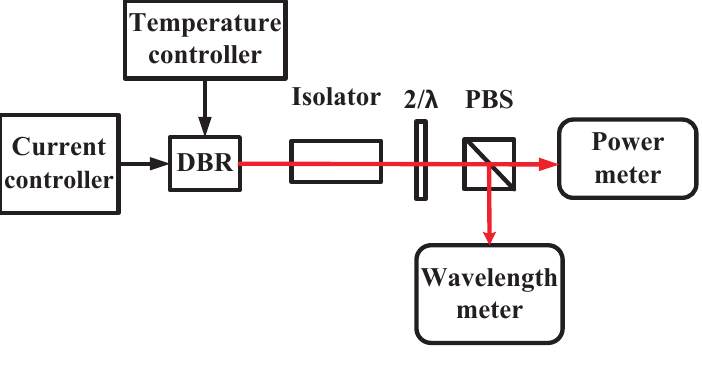
Figure 2. Experimental